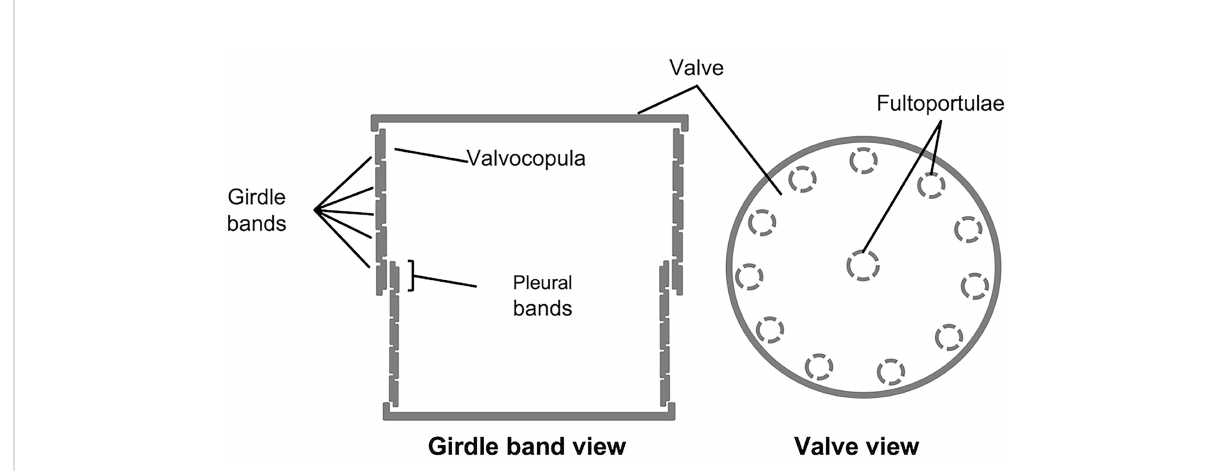
FIGURE 1 Schematic representation of T. pseudonana ’ s frustule, in girdle band view (left) and valve view (right); modi fi ed from Fattorini and Maier,